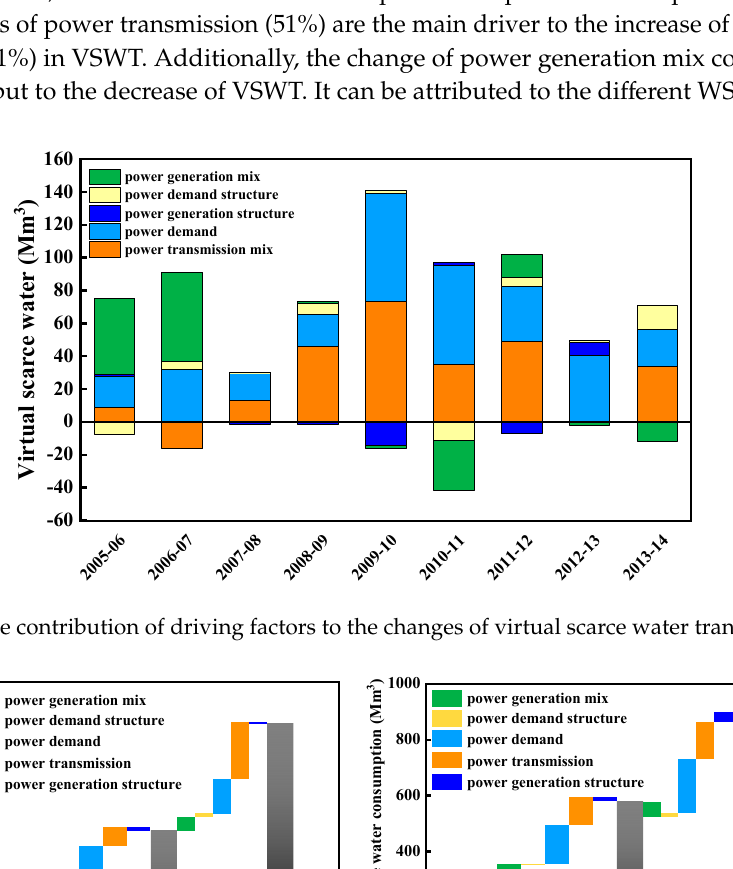
Figure 5. The contribution of driving factors to the changes of virtual scarce water transmission.